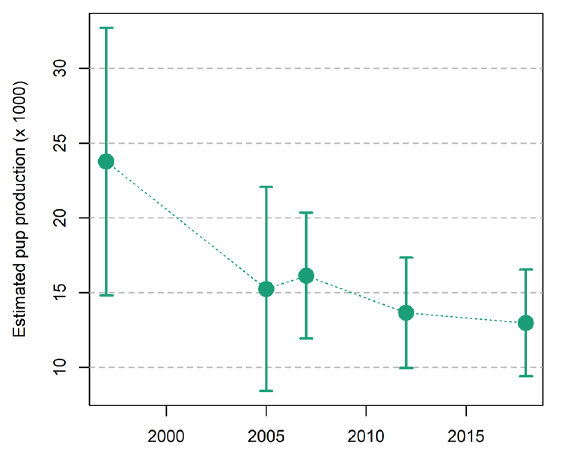
Figure 8. All pup production estimates for hooded seals, based on aerial photo surveys, since the start of surveys. The accuracy of estimates obtained from aerial surveys is dependent on the degree to which the possible sources of error are minimised. In assessing the relative importance of different sources of bias when estimating seal abundance from aerial surveys, Myers & Bowen (1989) concluded that the greatest source of bias arose from missing whelping